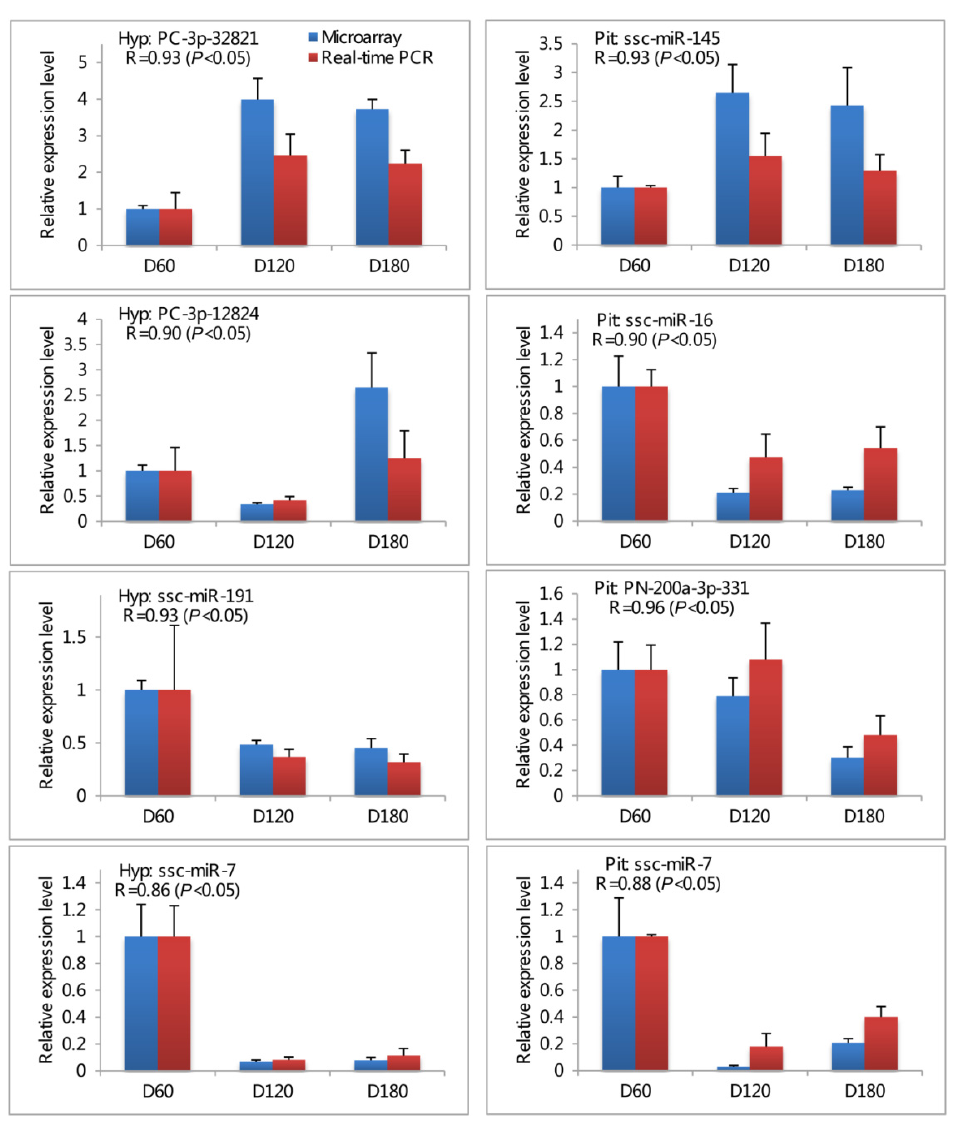
Figure 3. Validation of microarray results using real-time PCR method. Expression levels of seven miRNAs (PC-3p-32821, PC-3p-12824, and ssc-miR-191 for hypothalamus; ssc-miR-145, ssc-miR-16, and PN-200a-3p-331 for pituitary; ssc-miR-7 for both hypothalamus and pituitary) were detected by microarray ( left ) and real-time PCR ( right